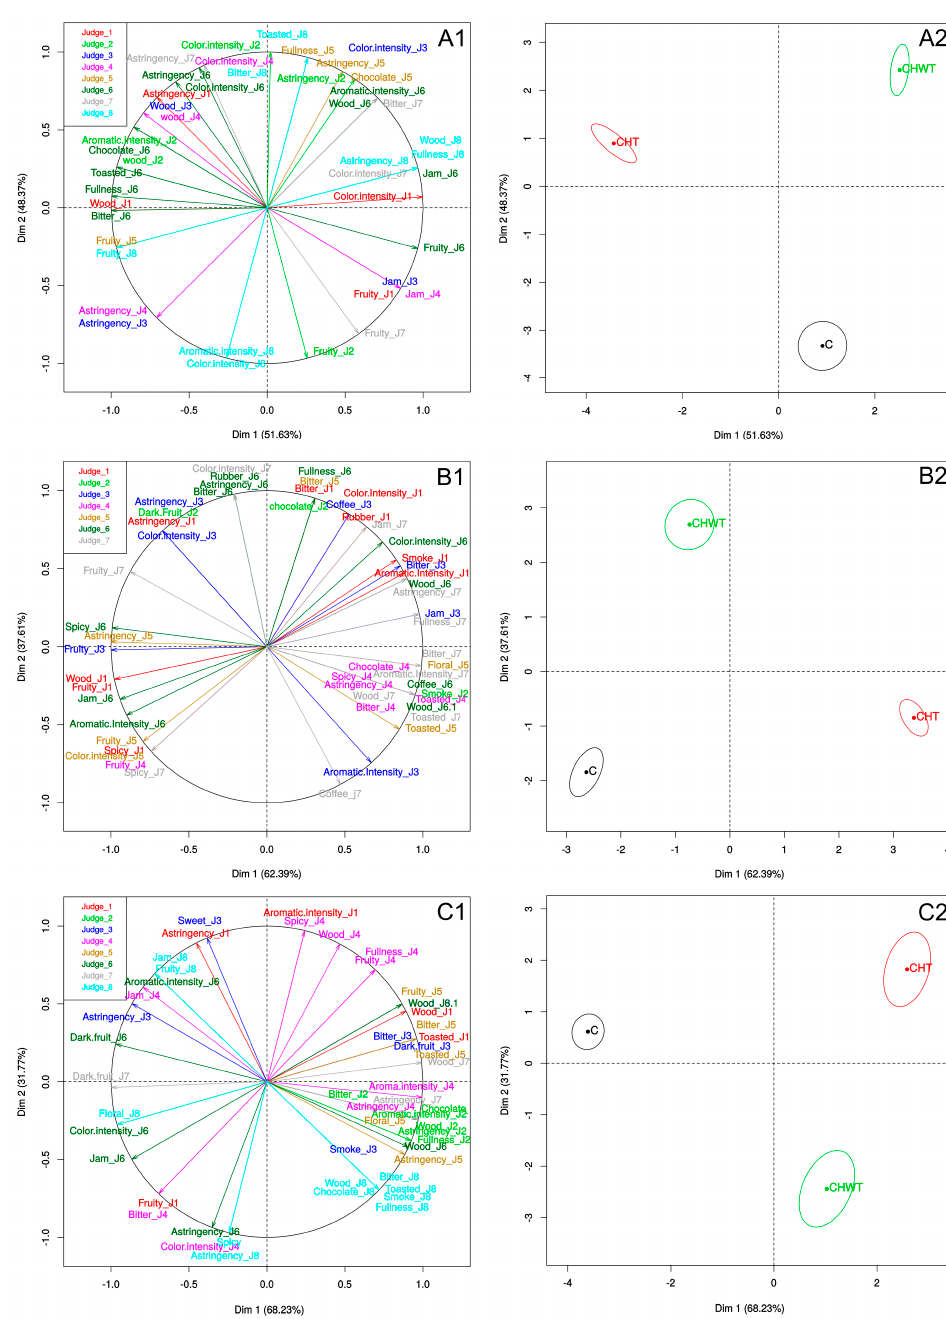
Figure 9. Multiple factor analysis (MFA) of Bonarda wines (Experiment B). (1) Circle plot of MFA correlations among judges; (2) MFA consensus plot showing wine scores. Confidence ellipses indicate 95% confidence intervals. ( A ) 1M; ( B ) 2M; ( C ) 4M. C, control; CHWT, untoasted vine-shoot chips; CHT, toasted vine-shoot chips; 1M, 30 days; 2M, 60 days; 4M, 120